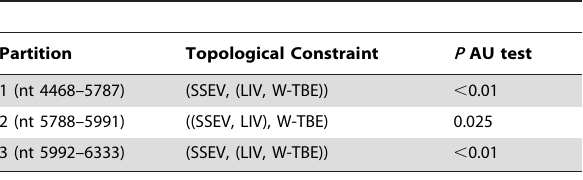
Table 3. Results of topological constraints and hypotheses testing using the AU